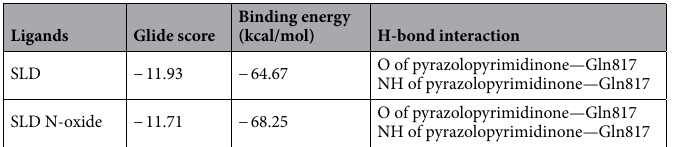
Table 9. The docking score, binding energy , and H-bond interactions of SLD and SLD